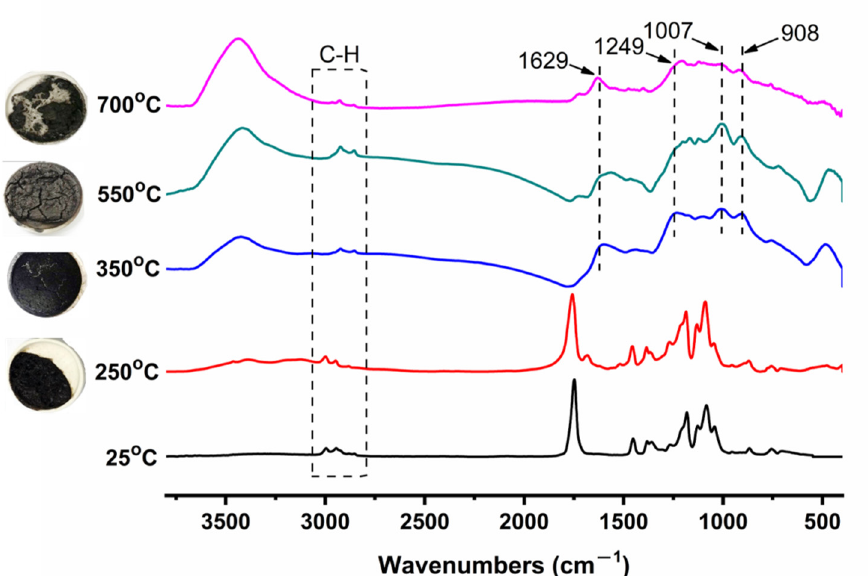
Figure 6. The FTIR spectra of the A2C1M1 sample after calcination in a muffle at different temperatures and their corresponding digital photographs.